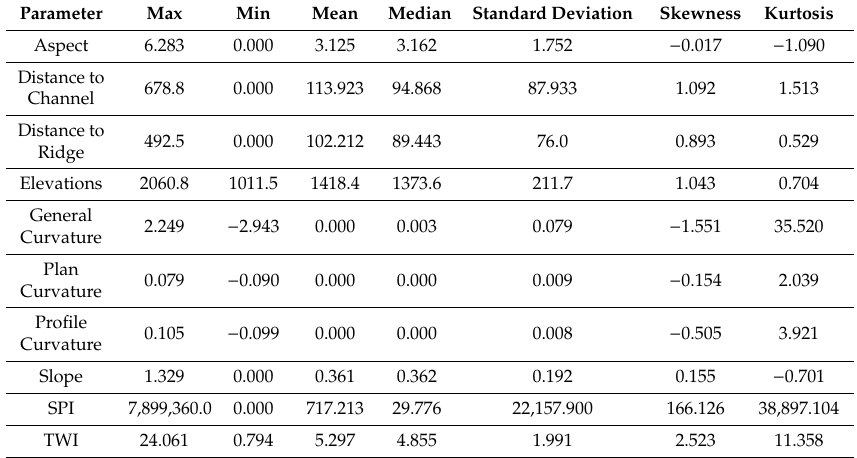
Table 3. Statistical summary of the values calculated from the topographic derivative parameters.